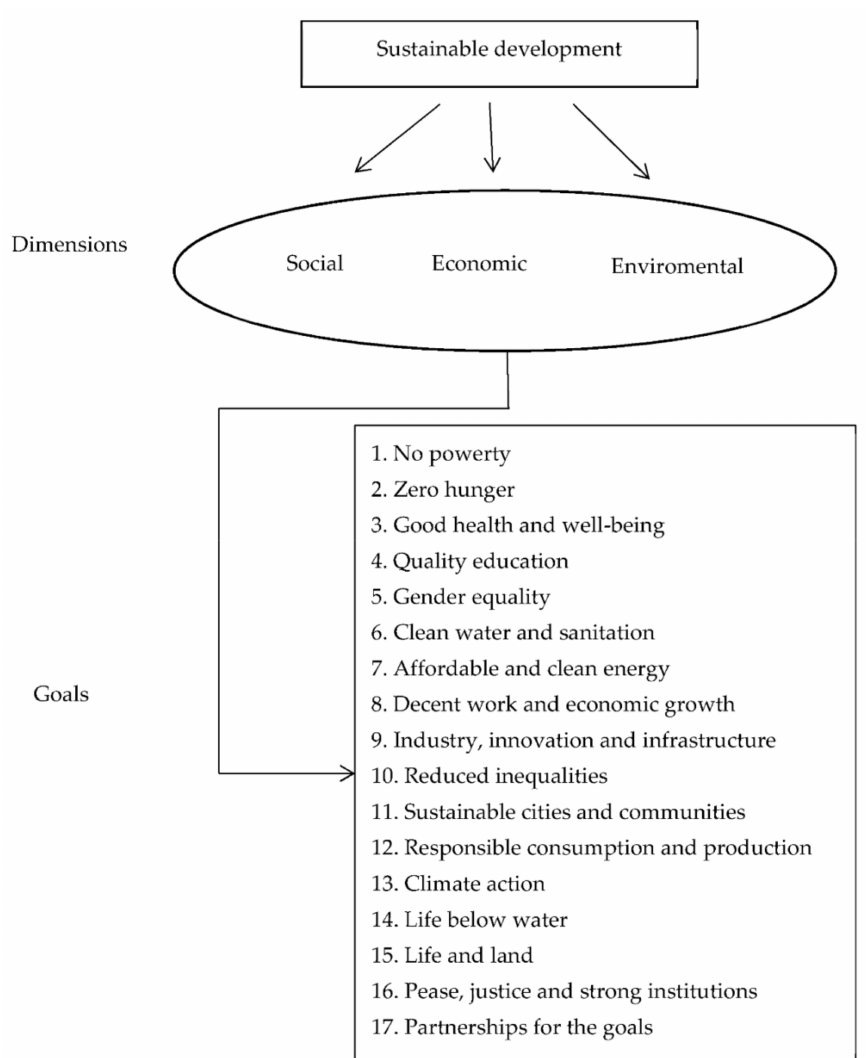
Figure 2. Sustainable development goals. Source: